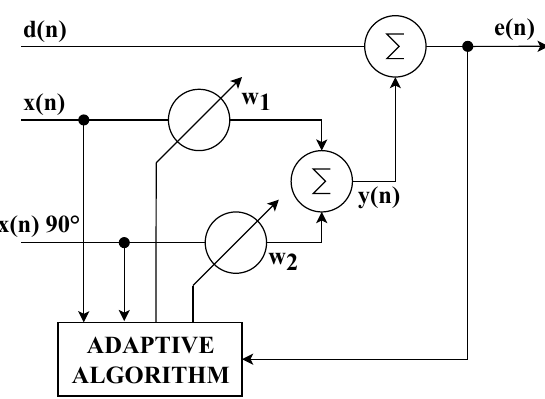
Figure 3. Block diagram of the notch adaptive